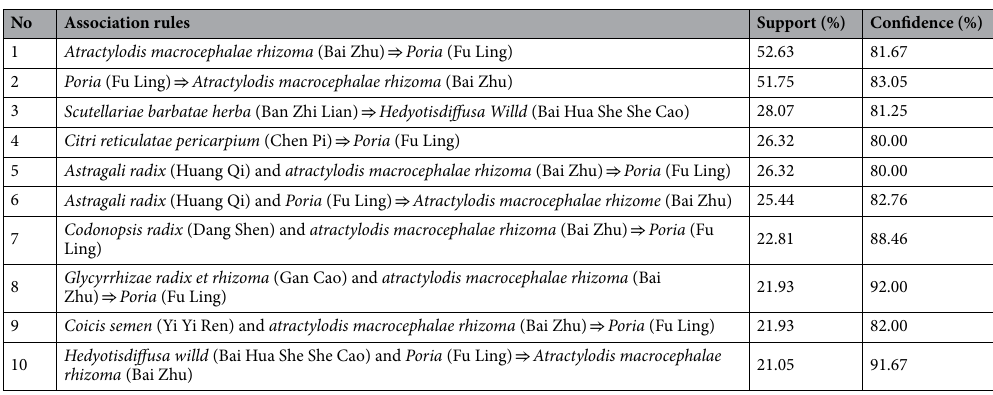
Table 1. Apriori algorithm-based association rules for herbs used to treat